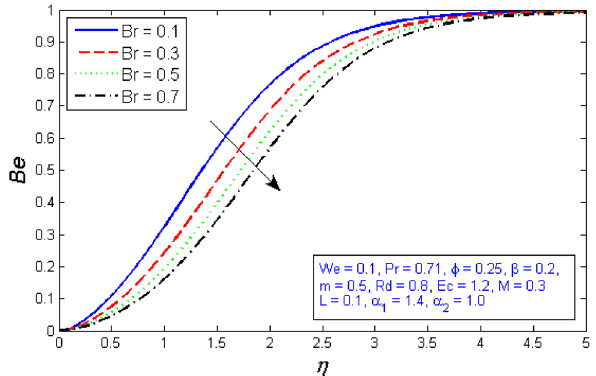
Figure 28. Represents variation of Bejan number for several number of Brinkman number Br .